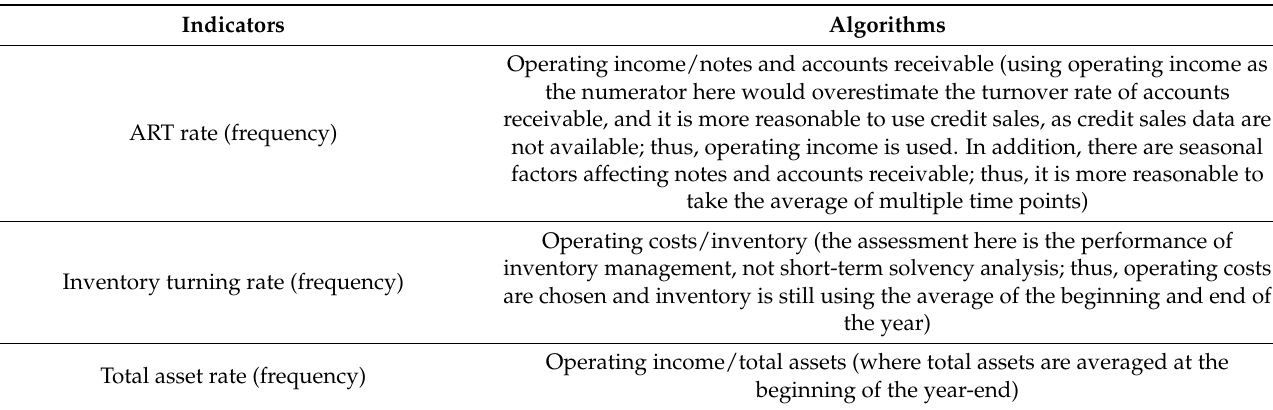
Table 9. Indicators and algorithms of operational efficiency of assets